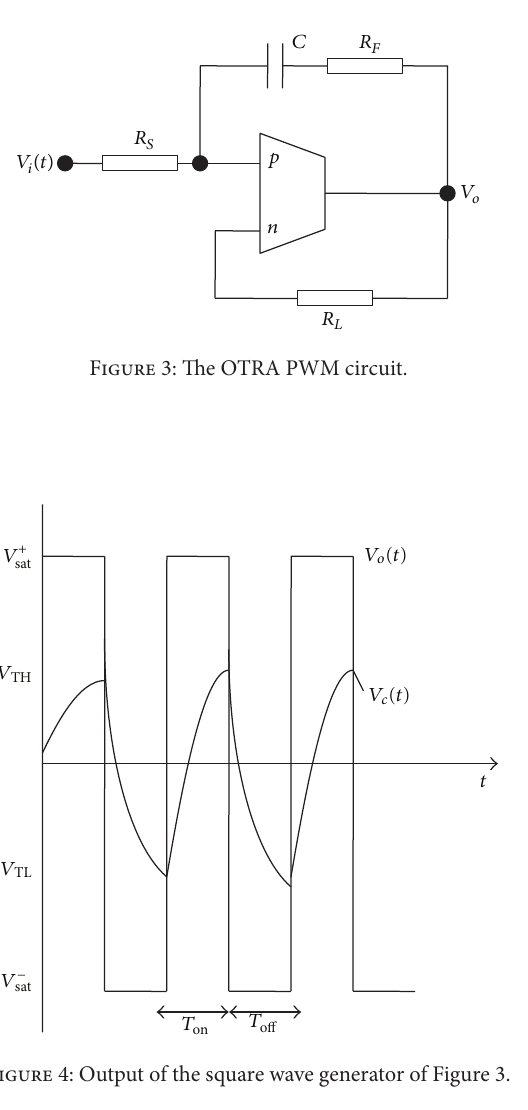
F 4: Output of the square wave generator of Figure 3.